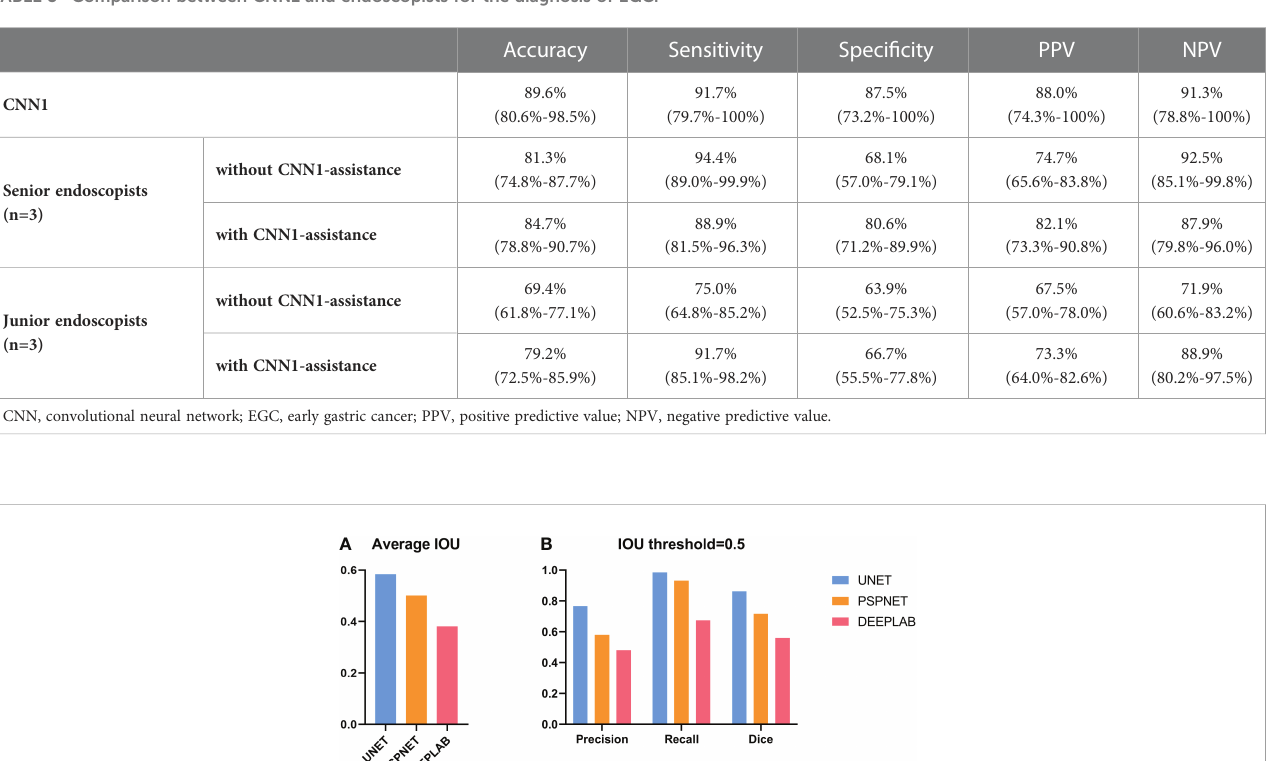
TABLE 5 Comparison between CNN1 and endoscopists for the diagnosis of EGC.